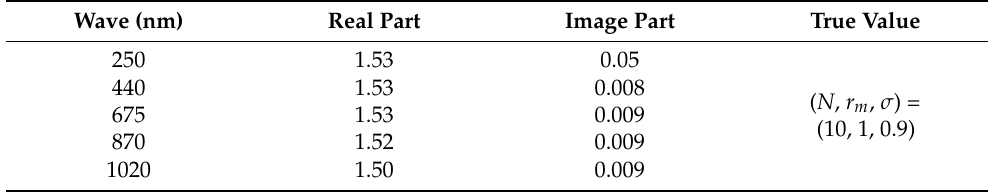
Table 3. True value and complex refractive index of different wavelengths.